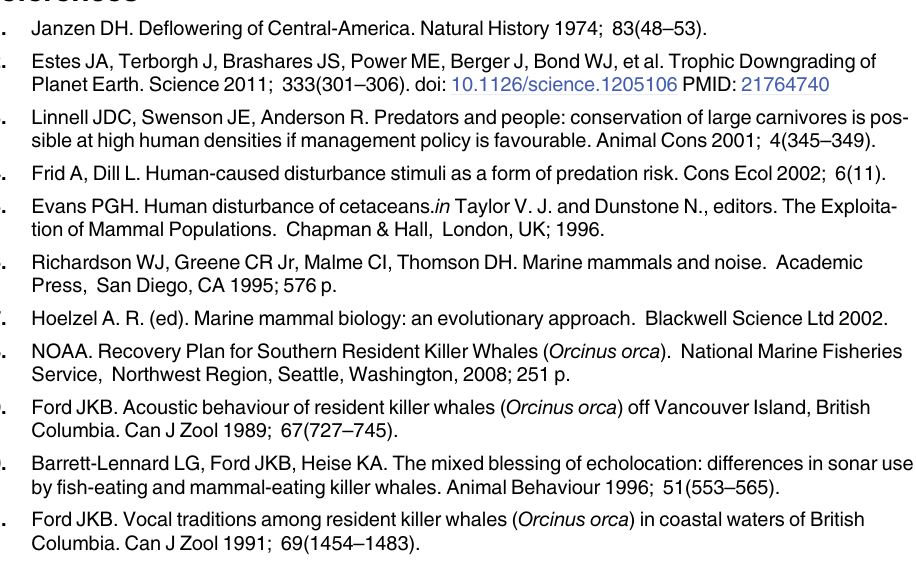
= 67.47, p < 0.001). 1, 55 = 1, 55